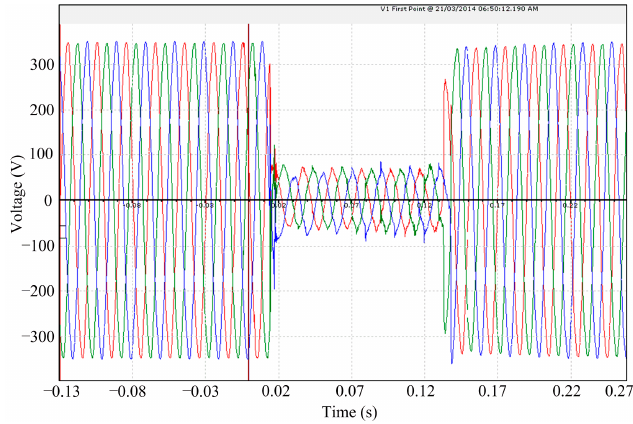
Figure 2. The waveform of sag captured from actual power system [26].